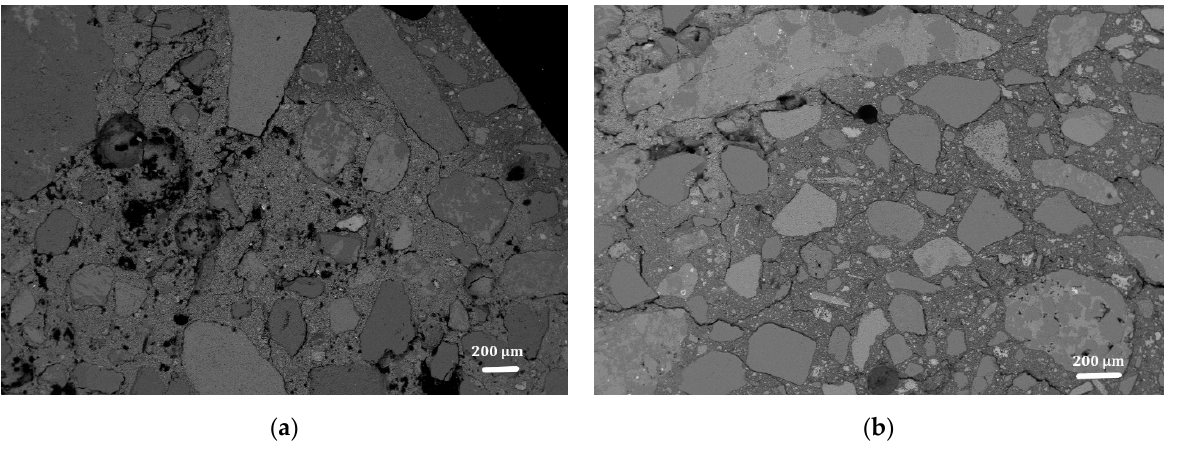
Figure 15. Backscattered electron (BSE) SEM images of mortars with 0% FC ( a ) and 0.3% FC ( b ).